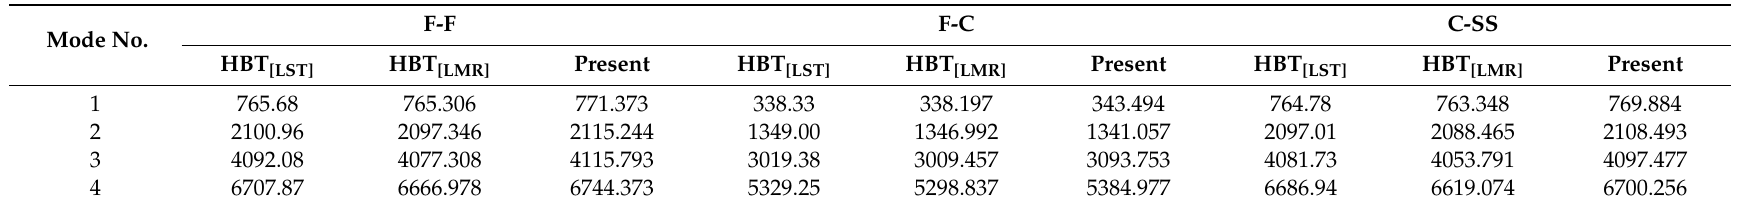
Table 4. Comparison of Ω (first five modes) for circular curved laminated beams subjected to various boundary conditions. Mode